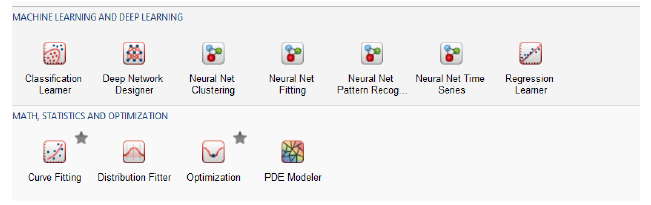
Figure 3. Neural Net Fitting.